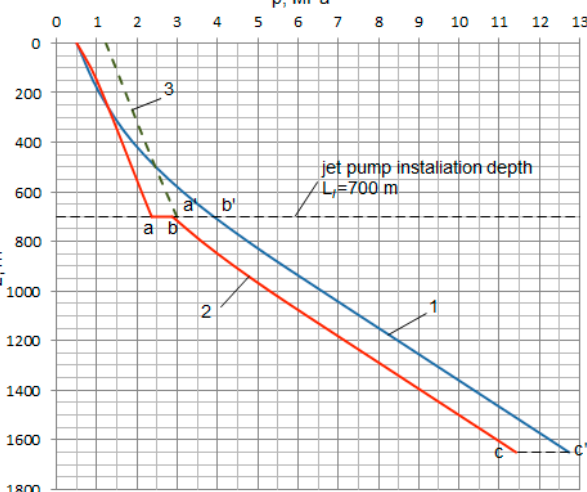
Figure 4. Pressure distribution between the sucker-rod pump and the wellhead: 1—without the jet pump; 2—with the jet pump ( f 3 / f 1 = 3); 3—with the jet pump after decreasing inlet pressure p w = 3.908 MPa.